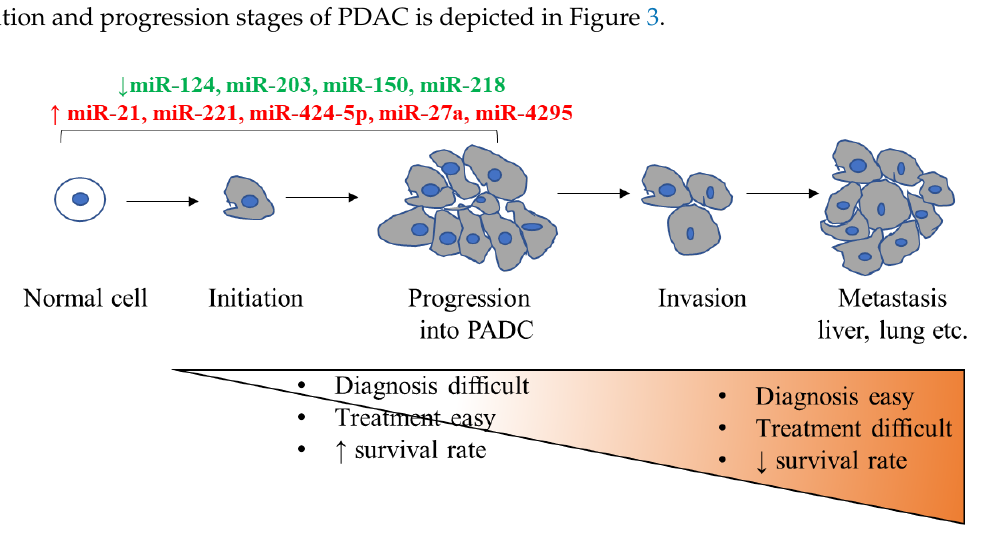
Figure 3. Schematic illustration of different stages of pancreatic ductal adenocarcinoma (PDAC). The list of miRNAs that are upregulated (in red color) and downregulated (in green color) during initiation and progression stages of PDAC are listed.